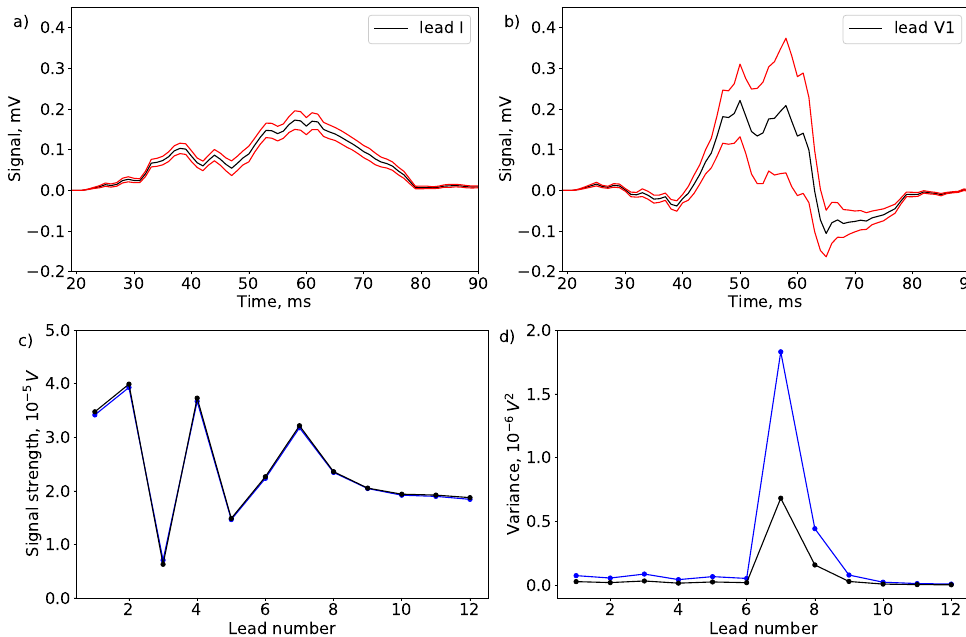
Figure 2. Characterization of the datasets. ( a ) The mean P-wave signal (black) of lead I and the range of ± one standard deviation (red) calculated over all 10,000 Monte–Carlo (MC) samples as an example of a lead with small overall signal variance. ( b ) The corresponding mean and 1 σ range for lead V1 with the highest overall variance. For a depiction of the corresponding signals for all leads, cf. appendix. ( c ) Left: The mean signal strength S for the 12 different leads, cf. Equation (9). Depicted are the Monte–Carlo sampled dataset with high input variability in blue and the dataset with small input variability in black, showing only minor differences. ( d ) Signal variance σ 2 of the 12 leads, cf. Equation (8). Depicted are the dataset with low input variability (DS 1 in black) and the MC-sampled dataset with high input variability (DS 3 in